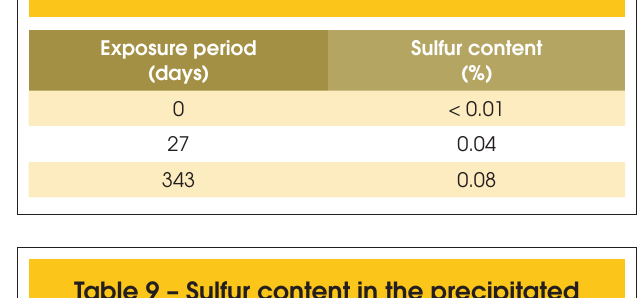
Table 9 – Sulfur content in the precipitated